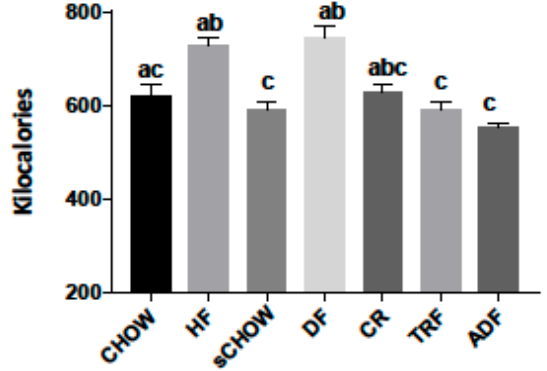
Figure 1. Total kilocalories consumed during the eight-week intervention period by male mice assigned to seven different dietary protocols. Values are mean ± SEM, n = 7–9 mice per group, using the Kruskal–Wallis test. Bars without a common letter differed. HF and DF > ADF ( p < 0.001). HF > sCHOW ( p = 0.010). HF > TRF ( p = 0.009). DF > sCHOW ( p = 0.016). DF > TRF ( p = 0.014).